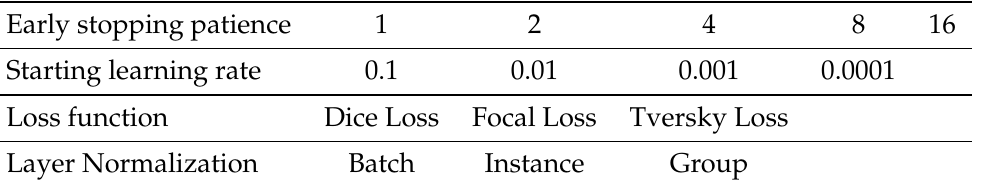
Table 1. Different hyperparameters tested for each U-Net architecture.